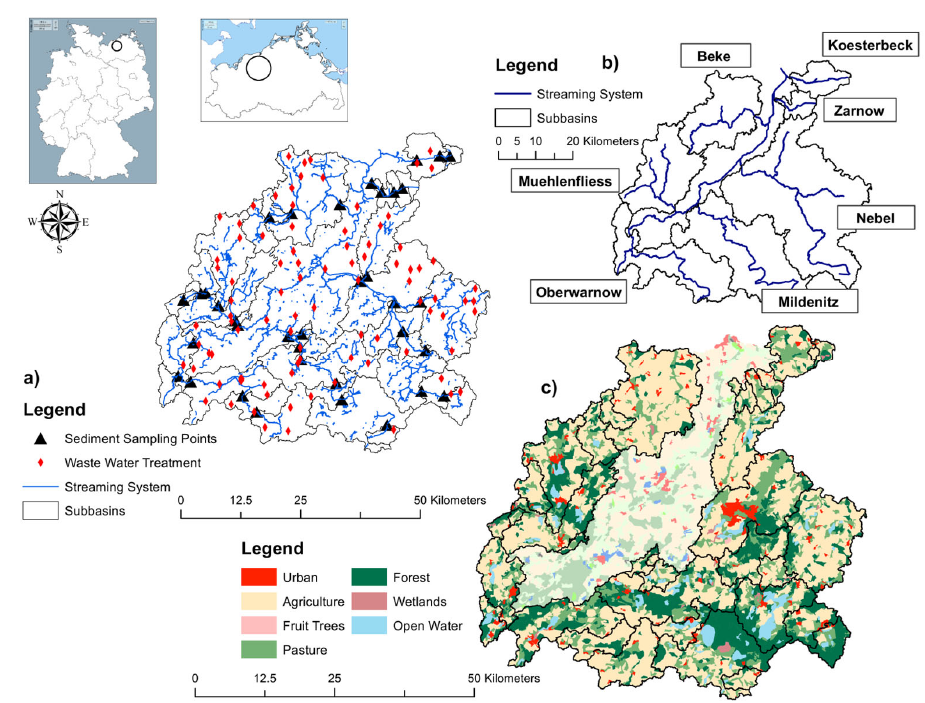
Figure 1. Study site and its location in Germany and the federal state of Mecklenburg ‐ Western Pomerania with ( a ) all subbasins, streaming systems, sampling points, ( b ) selected subbasins, and ( c ) land use. Areas with decreased saturation in ( c ) are located in the uninvestigated main stream.